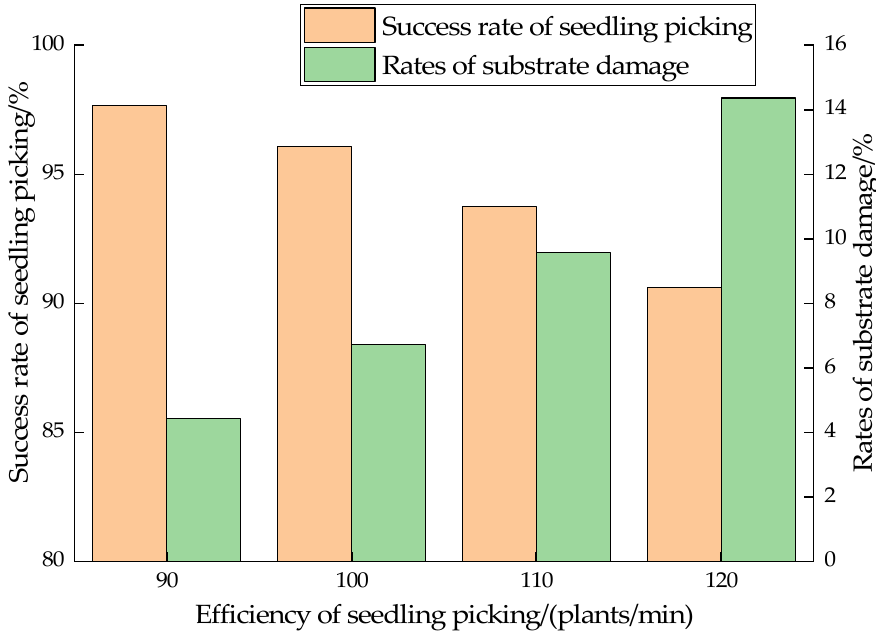
Figure 14. Results of seedling sampling test.